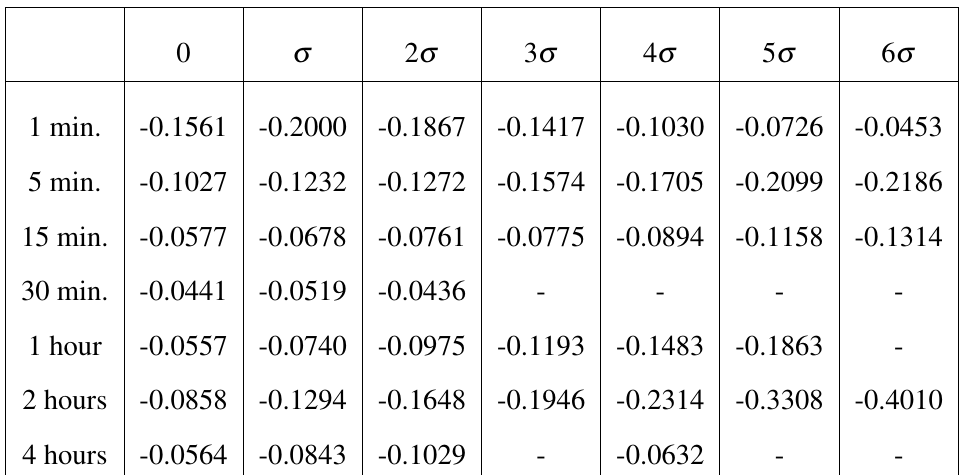
Table 4. Correlation coefficients by timeframe (row) and size of jump